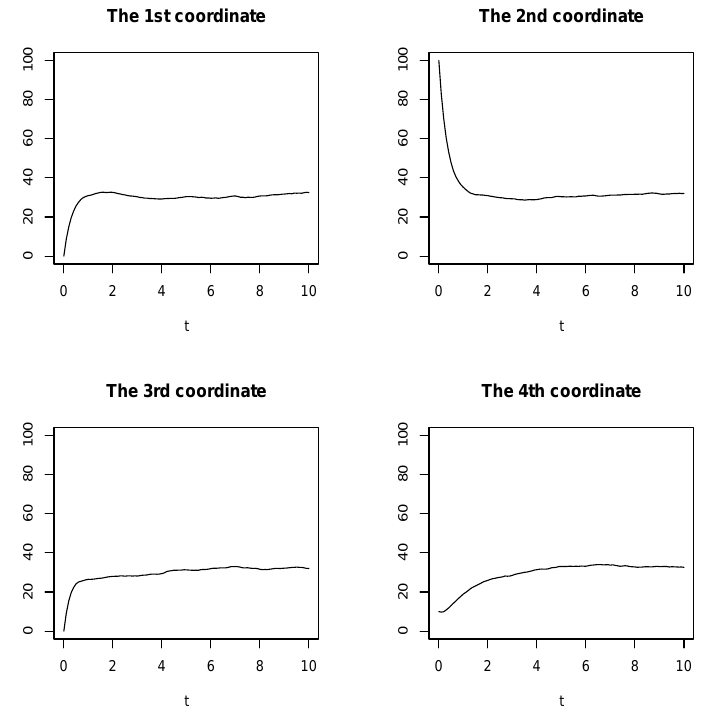
Figure 2. The trajectories of a sample solution to Example 1, where H = 0.75.